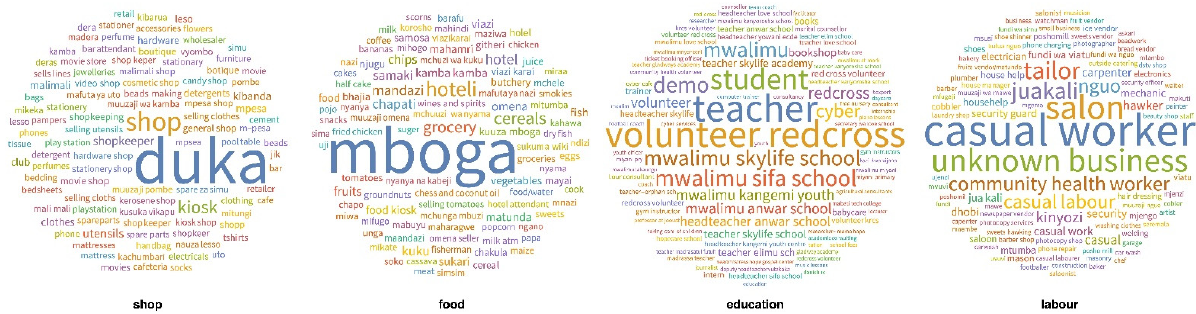
Figure 8. Breakdown of Four Business Types into Vendor or Wage Earner Descriptions Chosen by Members. Word cloud is weighted by membership numbers in each sector.